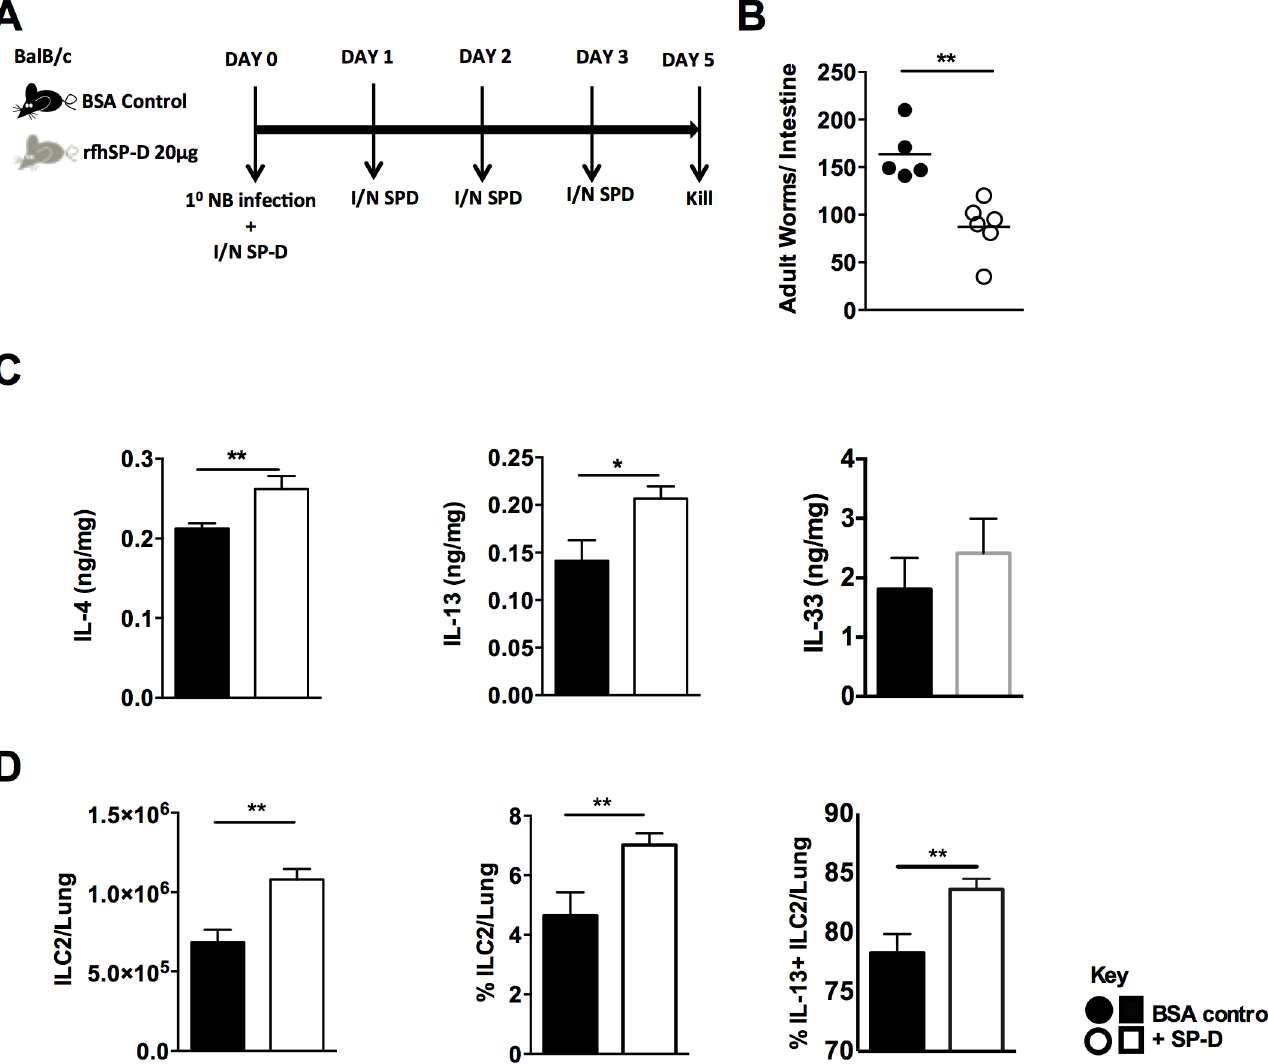
Fig 4. Intra-nasal administration of SP-D enhances protective immunity to N . brasiliensis . rfhSP-D treated or untreated mice infected with N . brasiliensis were killed at day 5 PI. ( a ). Intestinal worm burdens were quantified at day 5 PI. ( b ). IL-4, IL-13 and IL-33 cytokine levels in lung homogenates were detected by ELISA at day 5 PI. ( c ). Total numbers, total percentage and percentage of IL-13 positive lung ILC2s (d) were quantified by FACS analysis at D5 PI Black bars: control mice. White bars: SP-D treated mice. Data are representative of 2 – 3 experiments. N = 5 – 6 mice per group. * P < 0.05, ** P < 0.01. doi:10.1371/journal.ppat.1005461.g004 PLOS Pathogens | DOI:10.1371/journal.ppat.1005461 February 22,